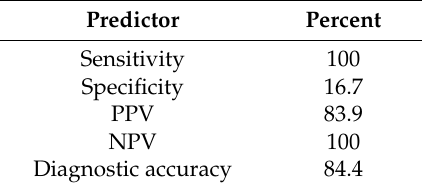
Table 3. The diagnostic value of the preoperative CT scan in the reseactability of tumors.